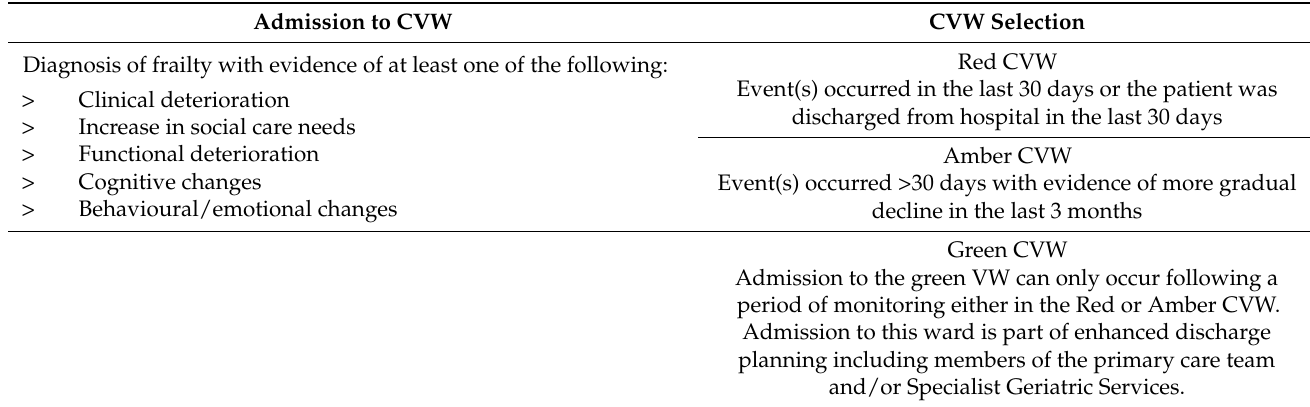
Table 2. Admission criteria to the Community Virtual Ward (CVW).